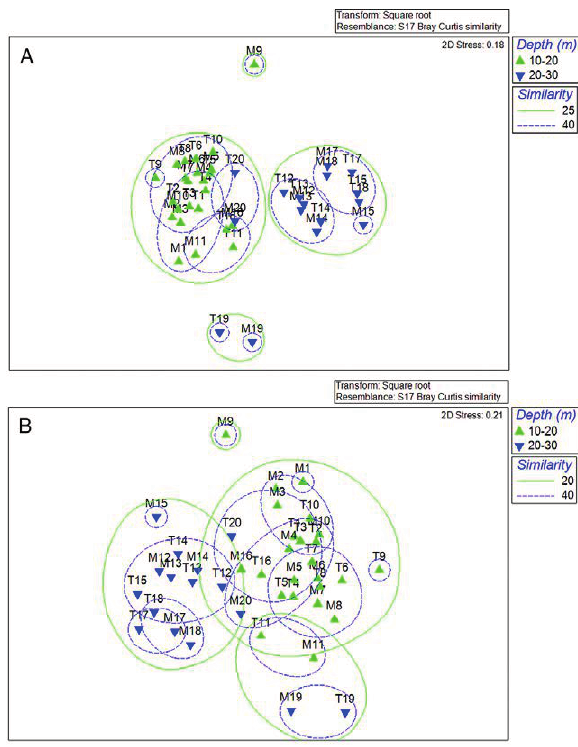
Fig. 6. – MDS plot (square root transformed data) of the abundance (A) and biomass (B) of all species (commercial catch, by-catch, commercial discards) caught in 20 trips with depth range (10-20 m and 20-30 m) as the factor and a cluster